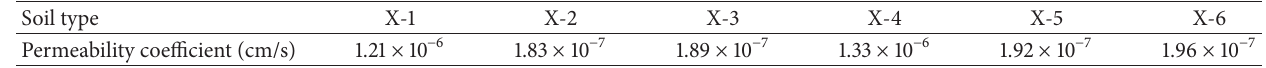
Table 5: Permeability coefficient of soils on the archaeological site.